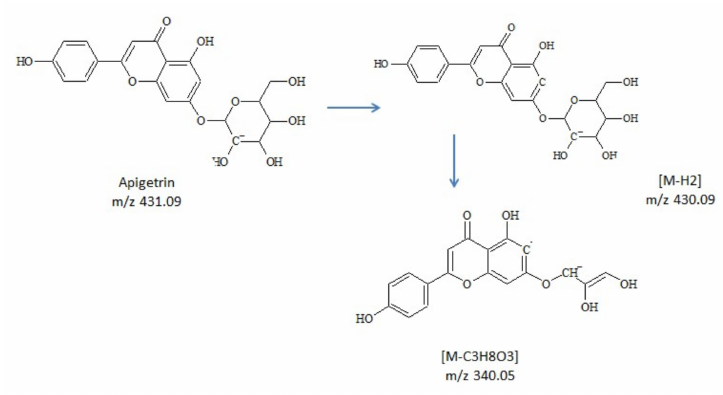
Figure 2. Proposed pathway for fragment m / z 340.05, specific for